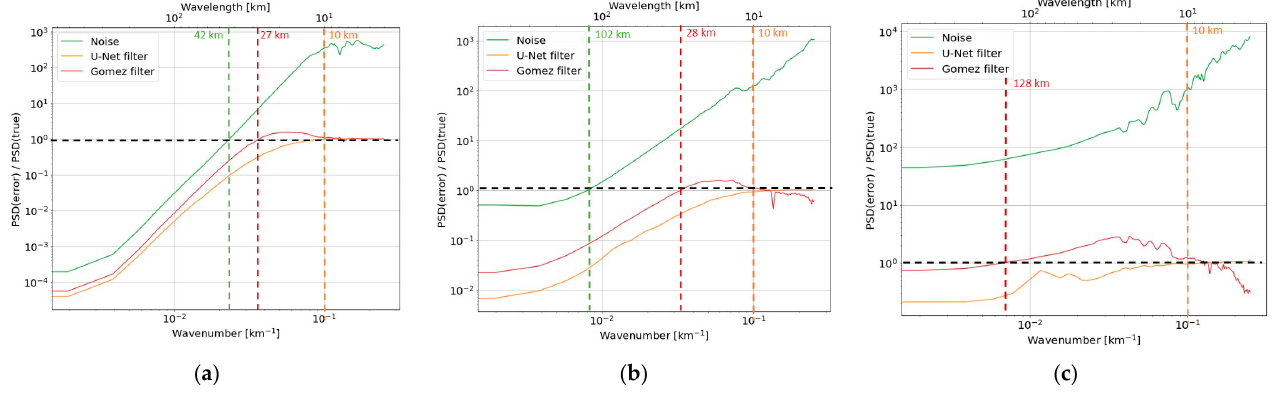
Figure 11. Examples of the method to determine the wavelength associated with the SNR = 1. It is the wavelength where the spectrum of the error over the spectrum of the ground truth crosses the value 1. If the spectrum is higher than 1 i.e., never crosses the value 1, the wavelength is setup as >1000 km like for the noisy field in ( c ). This example is calculated from the spectrums shown in Figure 10 i.e., ( a ) is computed from the SSH field, ( b ) from the first derivative and ( c ) from the second derivative over the eNATL60 domain and on the test dataset (year 2010). In green, the wavelengths of the noisy signal are, respectively, 42 km, 102 km and >1000 km. In red, the wavelengths of the SSH denoised by the Gomez fi lter are, respectively, 27 km, 28 km and 128 km. In orange, the wavelengths of the SSH denoised by the U-Net are 10 km.